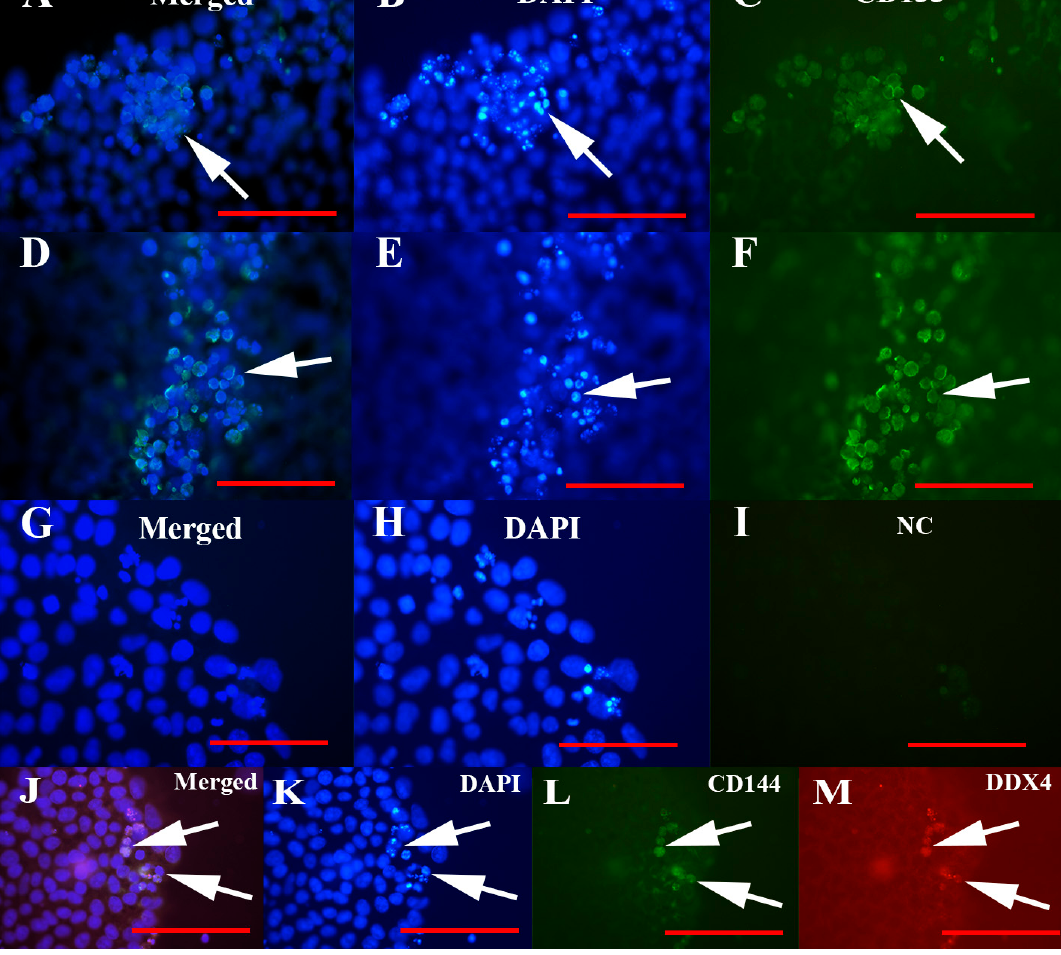
Figure 7. CD133 expression of VSEL-like stem cells in human embryonic stem cell (hESC) cultures and its coexpression with the DDX4 marker. ( A – F ) Expression of the CD133 marker, ( G – I ) negative control, and ( J – M ) coexpression of the markers CD133 and DDX4. Fluorescence microscope. Legend: green fluorescence—positivity for CD133; red fluorescence—positivity for DDX4; blue fluorescence—genetic material stained blue after DAPI staining. Red bar: 50 μ m.